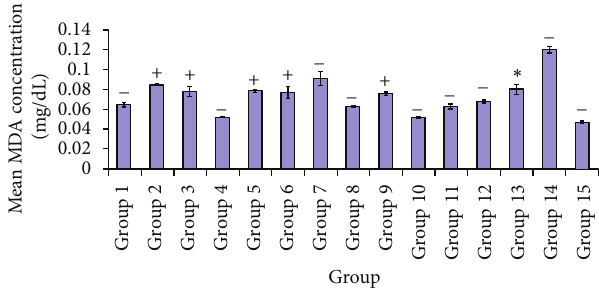
Figure 9: Comparative effect of the various plant extracts on malondialdehyde